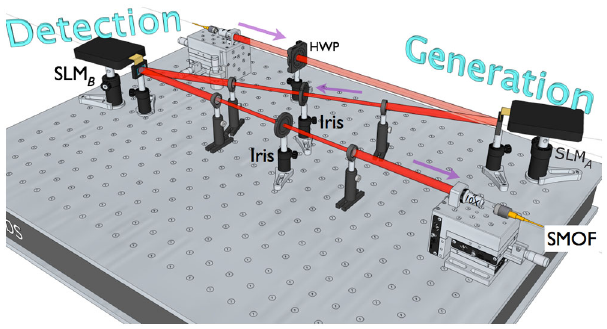
FIG. 2. Experimental setup for generating and detecting OAM photonic qudit states. The signal photon generated via sponta- neous parametric down-conversion (not shown) is spatially cleaned and sent into the main setup via a single-mode optical fiber (SMOF). Photonic qudit states (SIC POVMs) are generated by a holographic approach in which the desired kinoform is displayed on the spatial light modulator A (SLM A ). A half-wave plate (HWP) optimizes the first order of diffraction on SLM A , since SLMs are polarization dependent. The mode j Ψ i produced by SLM A is then projected onto a SIC POVM element SLM B . The resulting far field is coupled into a SMOF, which selects the TEM 00 -like component. We implement two 4 f systems with unit magnification to image SLM A onto SLM B and SLM B onto the microscope objective. Irises are used to select the first order of diffraction at the far-field plane of SLMs, where higher diffraction orders are well